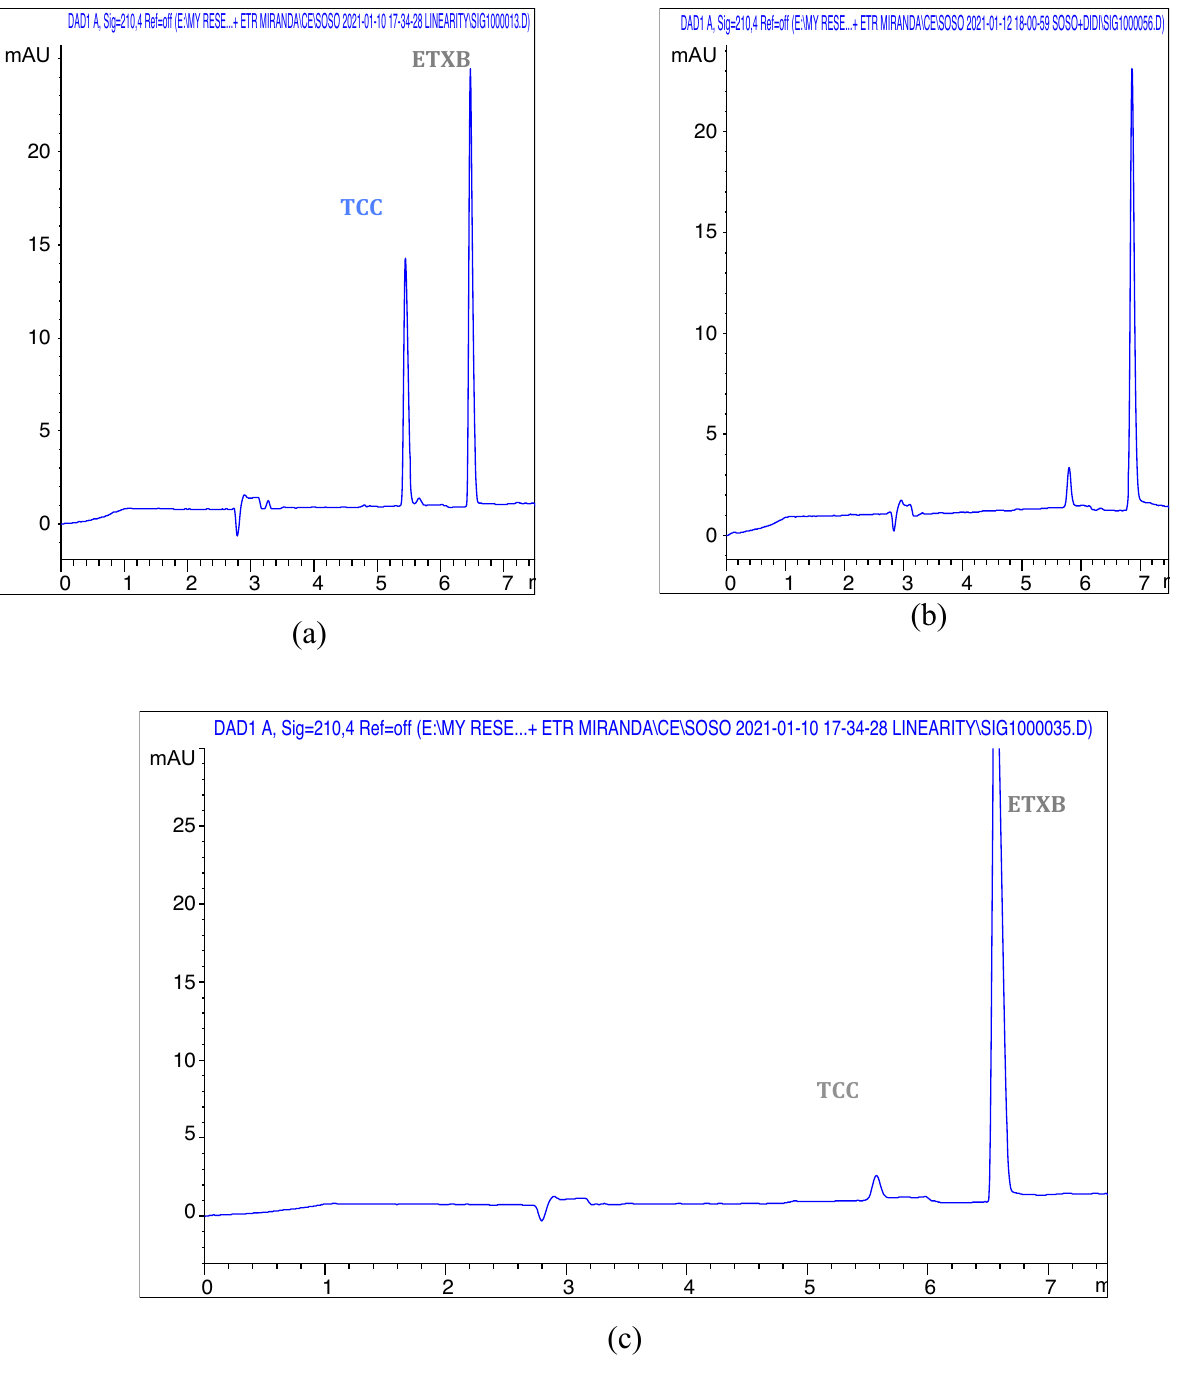
Figure 2: Typical MEKC electropherograms of standard mixtures of ( a ) 40 and 40 μ g · mL − 1 , ( b ) 5 and 37.5 μ g · mL − 1 , and ( c ) 5 and 75 μ g · mL − 1 of TCC and ETXB, respectively. Simulating the ratios of 1:1, 1:7.5, and 1:15 of